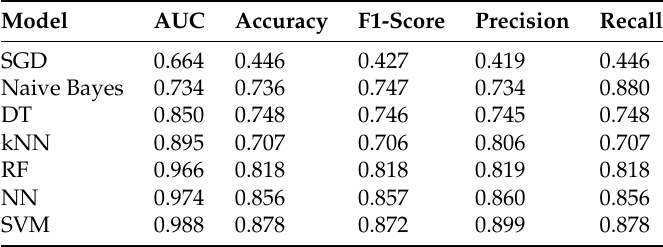
Table 6. Classification results of seven traditional ML classification